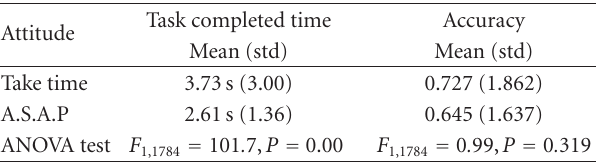
Figure 7: Percentage of chosen objects across subscreen at X - Y plane: (a) user attitudes; (b) interaction modalities. Table 3: Impact of user attitudes on task completion time and accuracy.